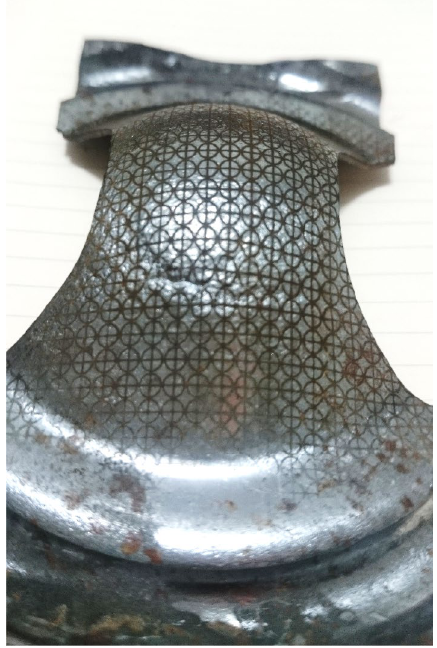
Figure 6. Forming limit sheet samples after Nakazima’s punch test.